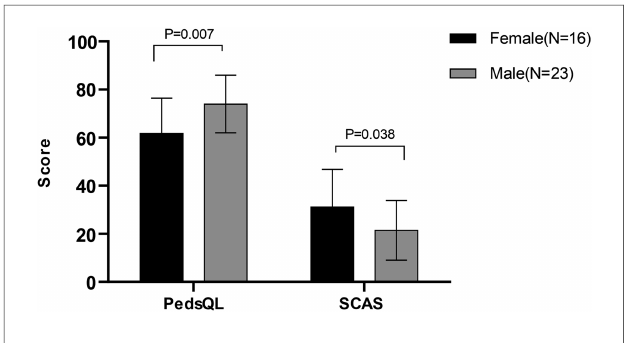
FIGURE 2 The PedsQL 4.0 and SCAS scores in different